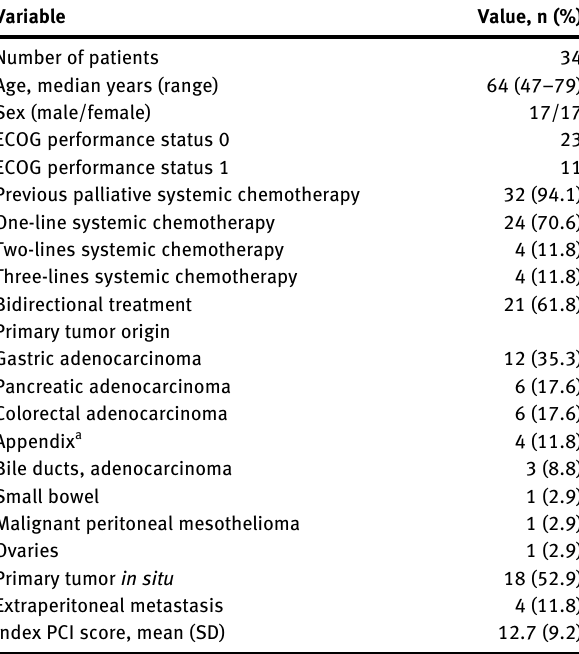
Table  : Baseline characteristics of patients with peritoneal metastasis treated with pressurized intraperitoneal aerosol